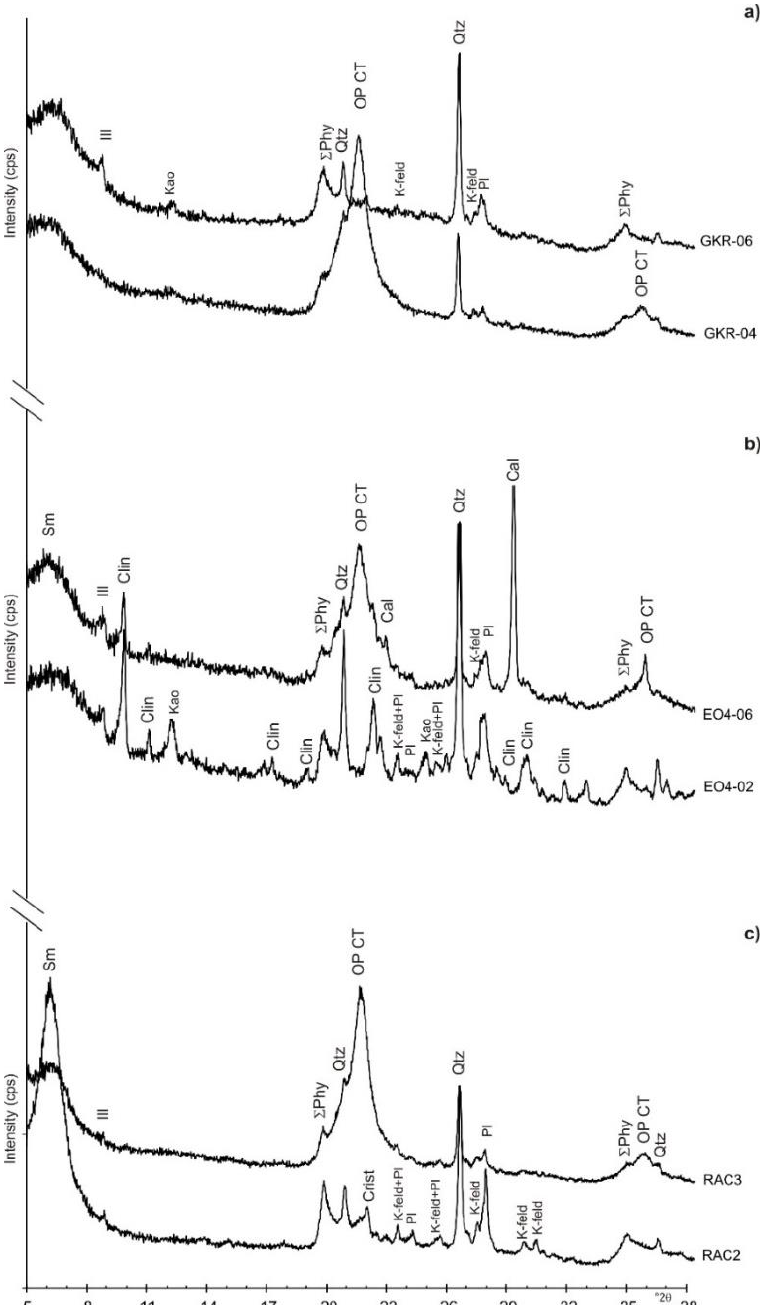
Figure 4. X-ray diffractograms for whole-rock samples: ( a ) Upper Kreyenhagen, ( b ) Lower Kreyenhagen, and ( c ) Moreno Formation. Mineral abbreviations are as in Table 1. Sample locations are shown in Figure